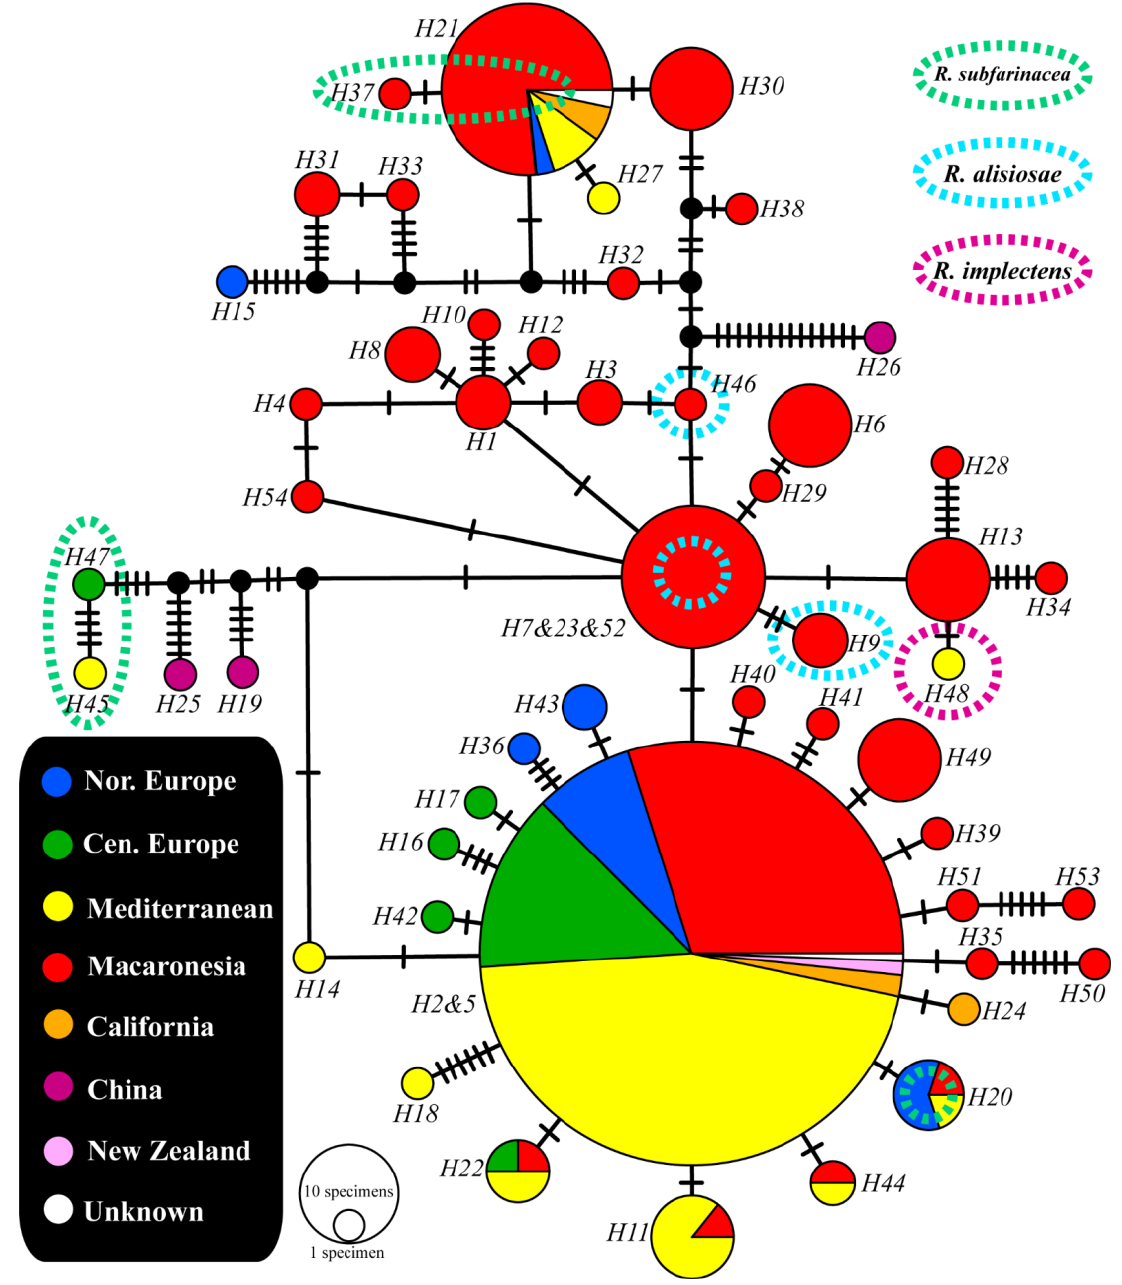
Figure 2. Statistical parsimony network for nrITS calculated using the extended sequence sampling that included available GenBank data of Ramalina farinacea and closely related species (the latter indicated with different colored dashed lines); circle colors indicate the geographic regions where specimens were collected (see legend below); the sizes of circles in each network are proportional to the numbers of individuals bearing the haplotype; circles may represent two or more haplotypes when these are separated only by indels; black-filled circles indicate missing haplotypes, and hatch marks indicate mutations. Note that species labeling was kept as originally submitted to GenBank.